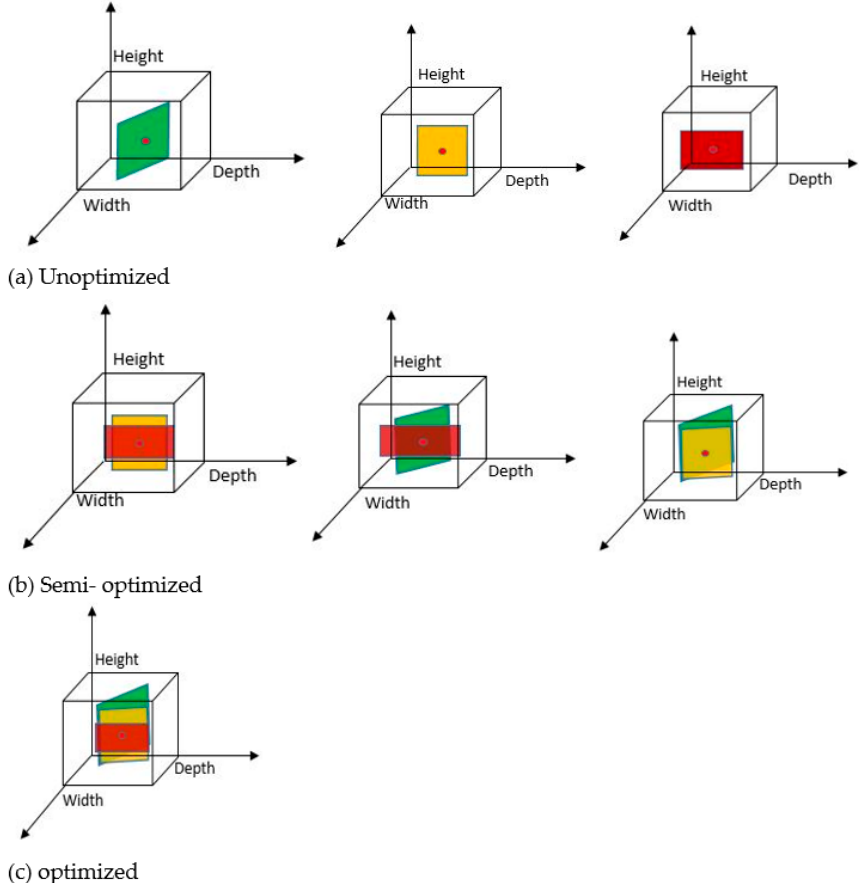
Figure 13. Implementation of Convolution based on Dimension (ConvDim): in ( a ), each kernel is applied to a pixel (represented by a small dot) independently; in ( b ), any two kernels are (height- width, height-depth, and width-depth) applied to a pixel simultaneously by allowing information to be combined using tensors; finally in ( c ), all kernels are applied to a pixel simultaneously, allowing information to be aggregated from the tensor efficiently. Convolutional kernels are highlighted in color (depth-wise, width-wise, and height-wise).